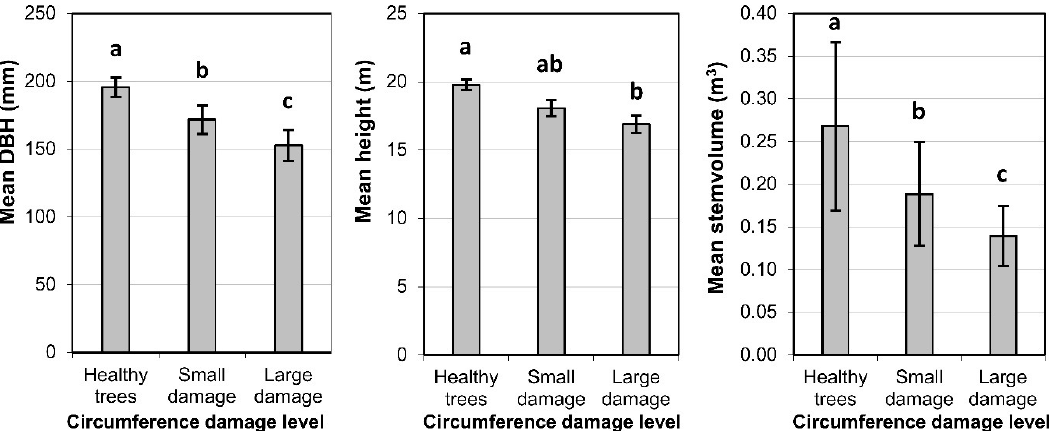
Figure 5. Testing the differences in mean DBH, mean height, and mean stem volume between selected levels of stem girth damage. The Kruskal–Wallis test with relevant multiple comparisons was used; selected level of significance was α = 0.05. Indices above bars depict statistically significant differences between variants (different letters indicate significantly different variants). Error bars depict 95% confidence interval.